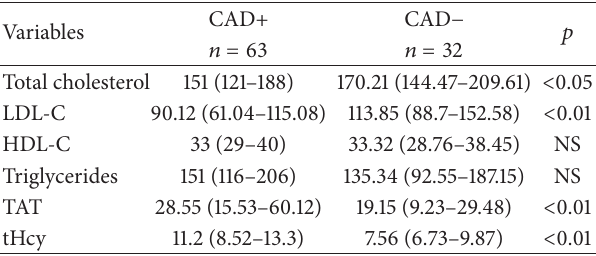
Table 2: Biochemical characteristics of the CAD+ and CAD − groups.